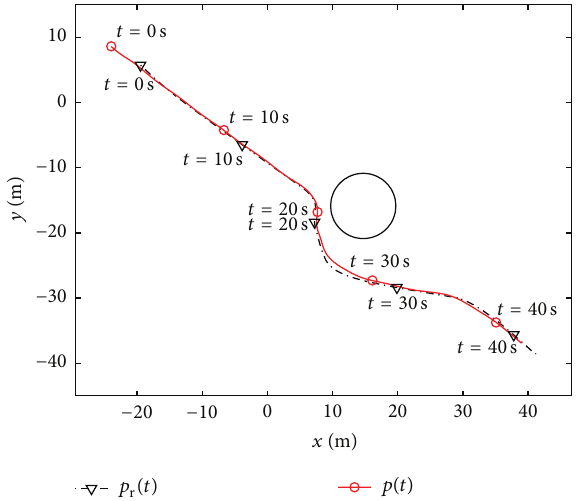
Figure 17: Obstacle avoidance at low speeds. Triangles and circles denote the location of reference system and vehicle, respectively, at certain instances in time.